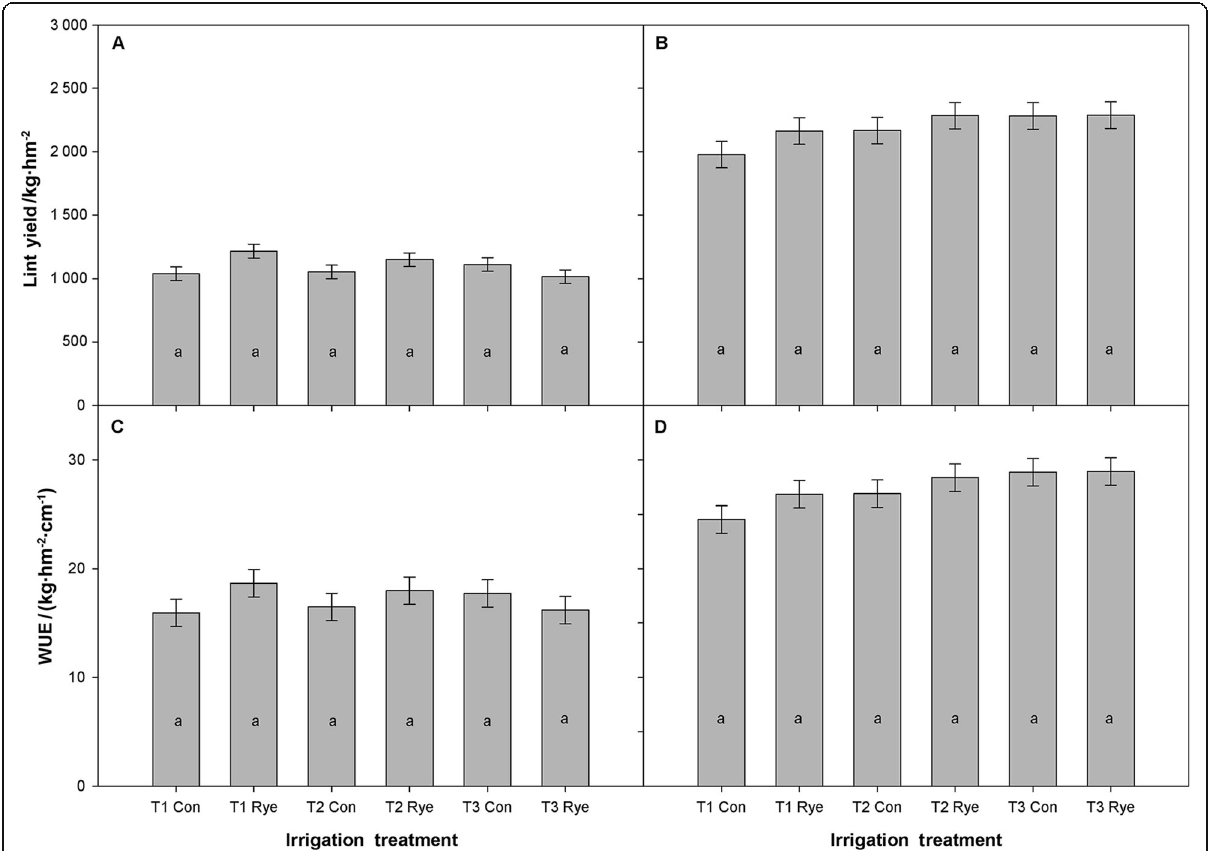
Fig. 6 Lint yield and water use efficiency (WUE) in the 2014 ( a , c ) and 2015 ( b , d ) growing seasons (kg·hm -2 ·cm -1 ) under irrigation regimes T1-T3 and planted into either conventionally tilled beds (Con) or a heavy rye cover crop residue (Rye) at a field site near Tifton, GA. Values are means ± standard error ( n = 6), and bars not sharing a common letter within a given year are significantly different ( P <